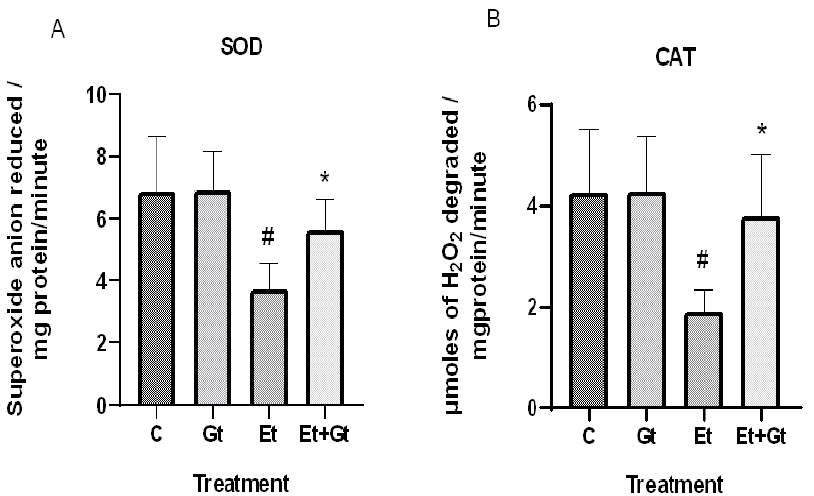
Figure 2. Changes in superoxide dismutase ( A ) and catalase ( B ) activities in cardiac tissue of control (C), 6-gingerol (Gt)-, ethanol (Et)- and ethanol + 6-gingerol (Et + Gt)-treated rats. The data were expressed as mean ± standard deviation (SD). # p < 0.05 compared with control and * p < 0.05 compared with ethanol treated groups.